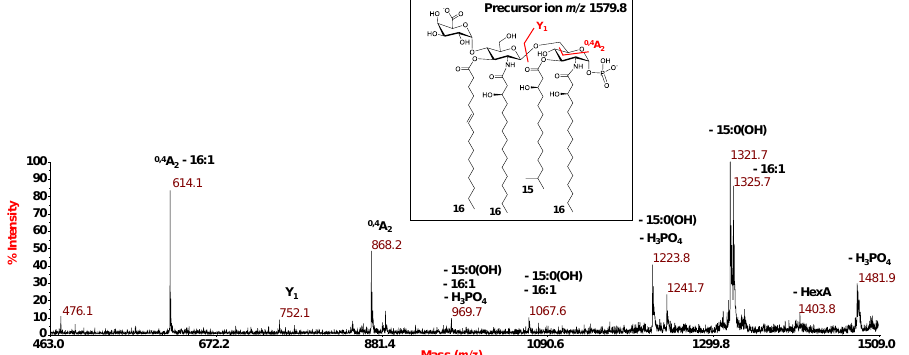
Figure 5. Negative-ion MALDI MS/MS spectrum of the precursor ion at m / z 1579.8, a representative ion peak of the cluster matching with tetra-acylated lipid A species from E. vietnamensis KMM 6221 T . The assignment of main fragments is indicated. The proposed structure for the lipid A species is reported in the inset. In this case, the representation of 15:0(3-OH) in its branching form is tentative. Since both the phosphate group and the HexA unit may be candidates to hold the charge, the proposed structure has been depicted carrying two negative charges for information purposes